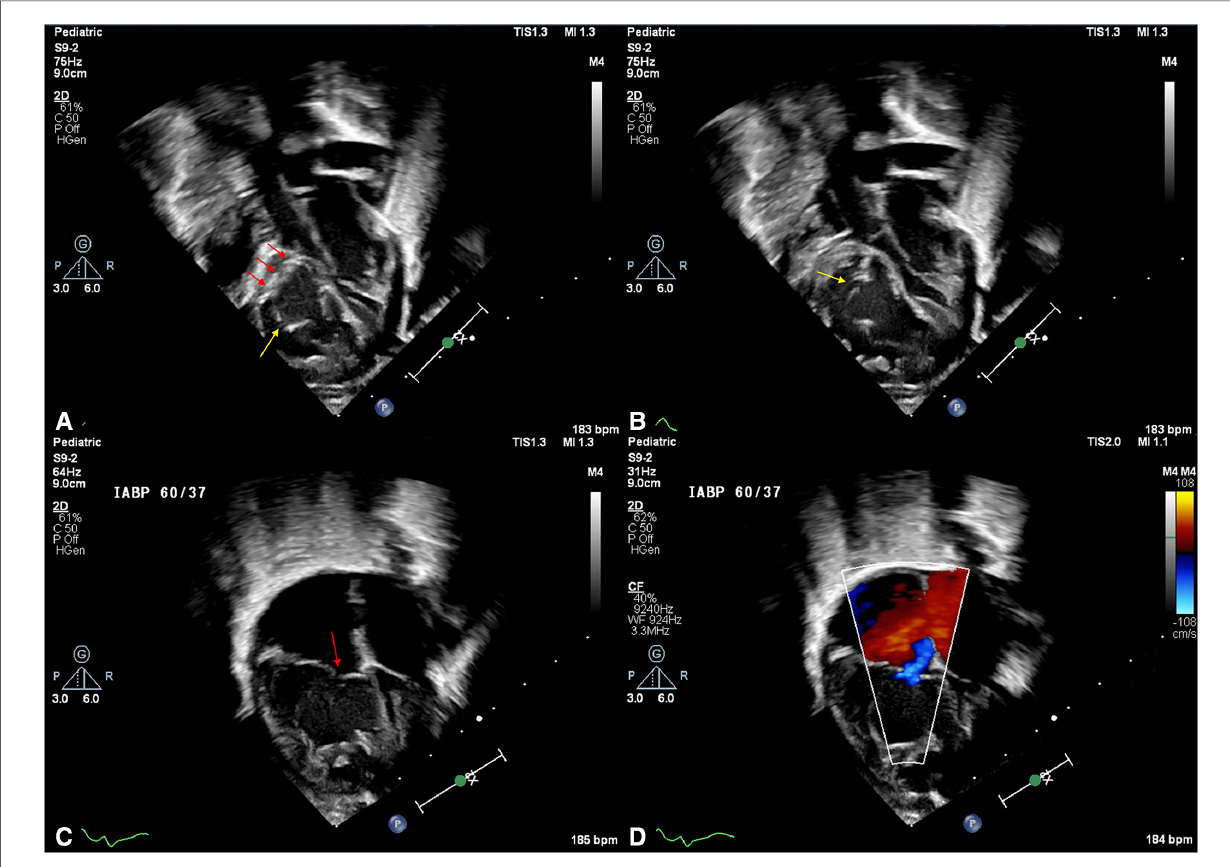
FIGURE 2 Tricuspid valve malformations in HLHS. ( A ) Subcostal view of the tricuspid valve in early-mid diastole. The anterior lea fl et free margin is bright and thickened (red arrows), and a deep cleft is noted at the antero-inferior commissure. ( B ) Subcostal view in late diastole. An additional cleft and nodules are noted on the anterior lea fl et (yellow arrow). ( C ) Apical 4 chamber view in early systole. Note the poor coaptation between anterior and septal lea fl ets (red arrow) and, ( D ) colour Doppler interrogation in the same view showing mild tricuspid